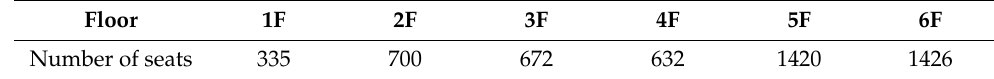
Table 2. Basic information of each floor.